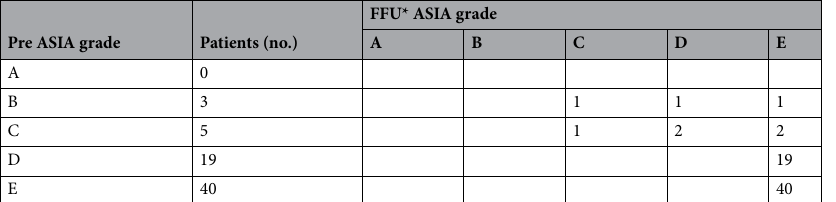
Pre ASIA grade Patients